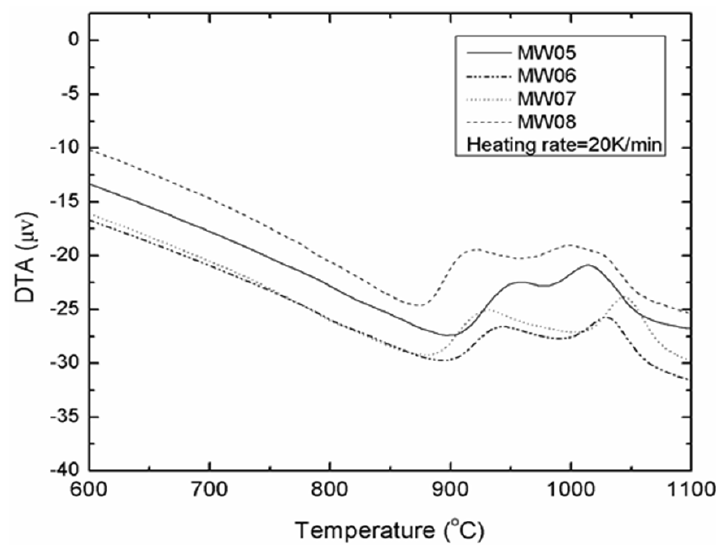
Figure 9. Non-isothermal DTA curves of the crystallization reaction of slag fiber.